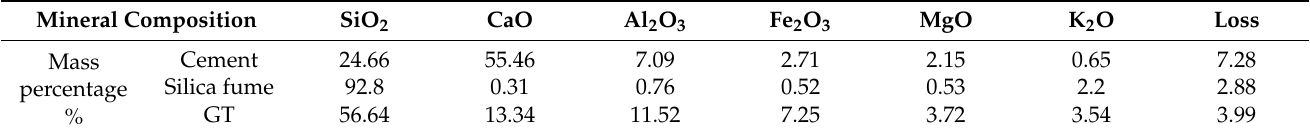
Table 2. Chemical composition of cement, silica fume and GT.